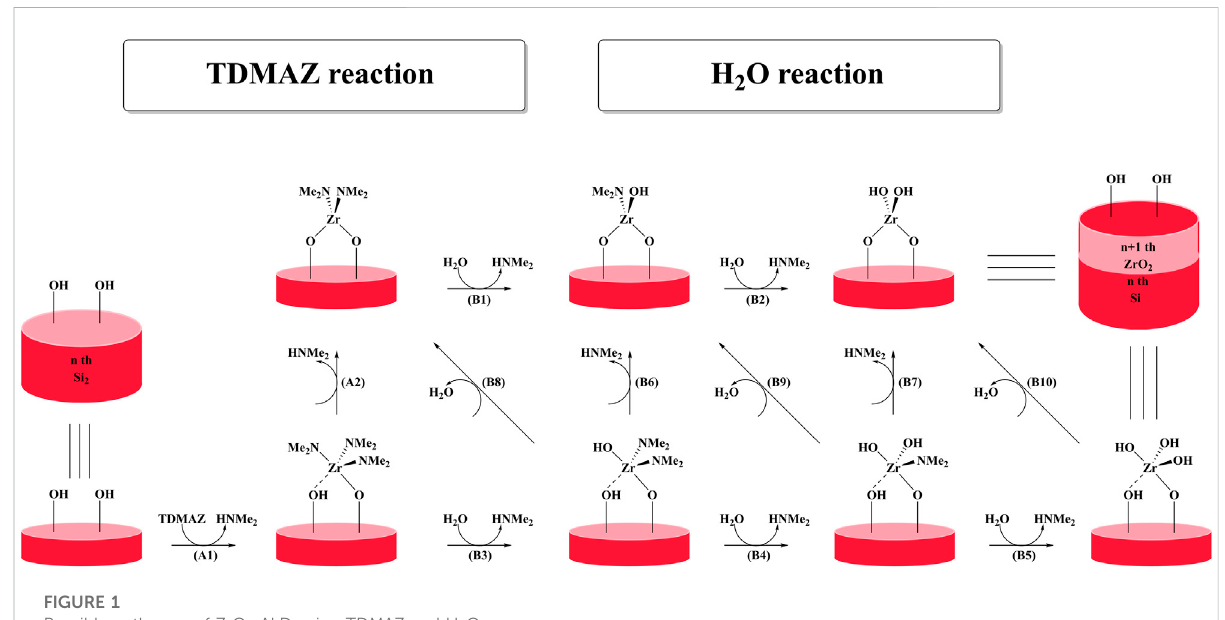
FIGURE 1 Possible pathways of ZrO 2 ALD using TDMAZ and H 2 O as